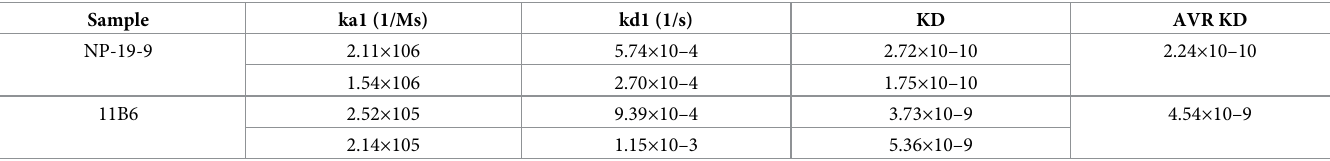
The neutralizing activity of individual NP-19-9 and 11B6, cocktail (NP-19-9 and 11B6) against six rabies viruses that were isolated in India were tested using the RFFIT and an animal viabil- ity test. Each test group was prepared at a concentration of approximately 1 μ g/ml and was car- ried out in Neuro-2a cells with 100 FFD of each virus (S3 Table in S1 File). The RFFIT 50 results showed a neutralizing activity against each six virus by all mAbs group tested (S4 Table in S1 File). For animal viability test, mice were infected with rabies virus SV1-SV6 (S4 Table in S1 File) and was treated either negative control, HRIG, NP-19-9, 11B6, or cocktail (NP-19-9 and 11B6). Representative survival rate change from SV2 infection and treatment is Table 6. Binding affinity of NP-19-9 and 11B6 to rabies virus G-protein. Sample